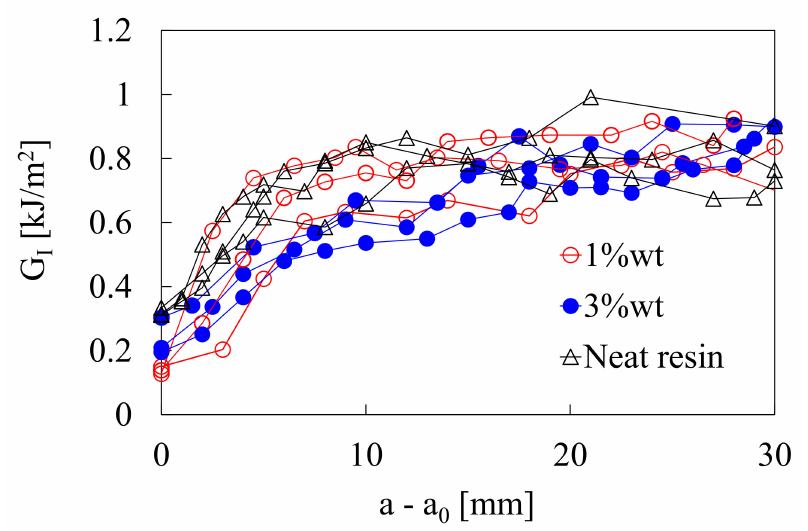
Figure 5. R-curves obtained from DCB specimens made of neat and nanomodified laminates